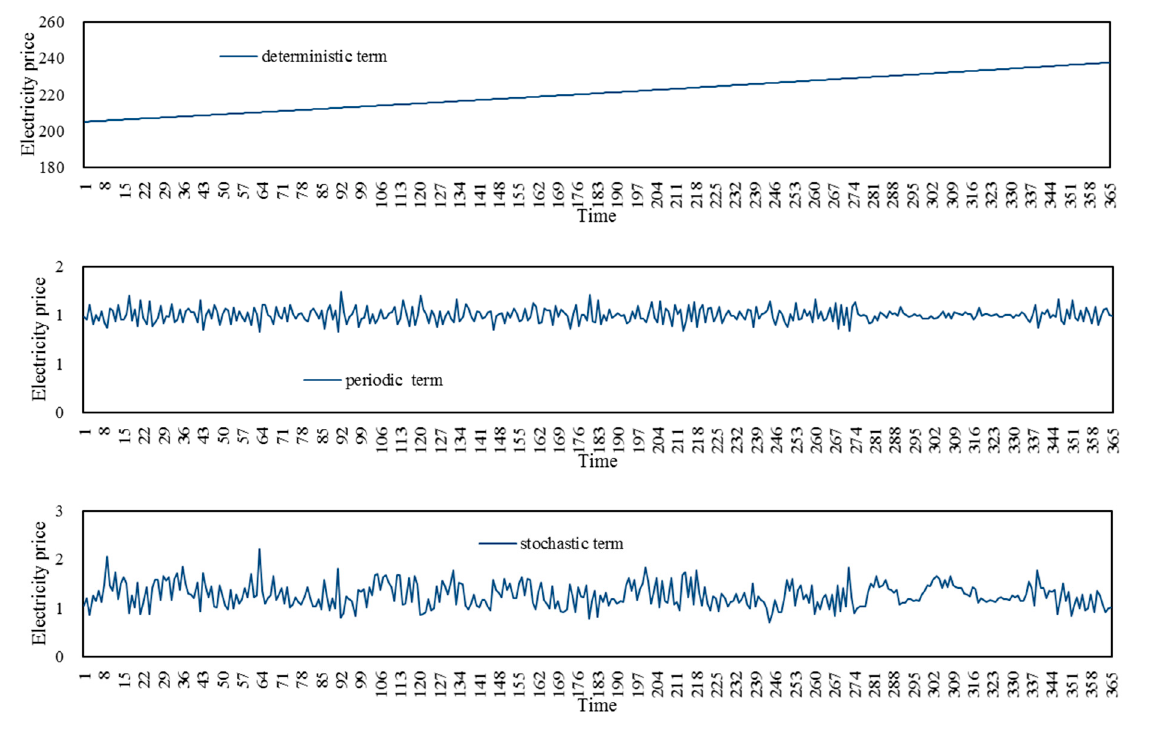
Figure 3. Decomposed deterministic term, periodic term, and stochastic term of original daily electricity price time series.